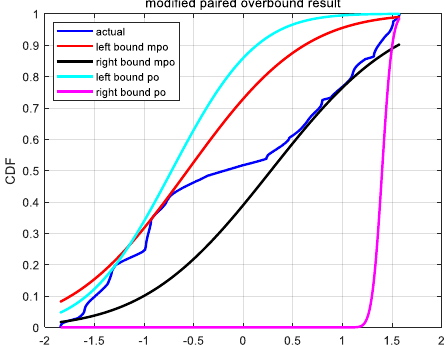
Figure 1. The empirical CDF and the overbound function obtained from the two paired overbound methods. The “MPO” in the legend stands for the modified paired overbound method, the “PO” in the legend stands for the paired overbound method.